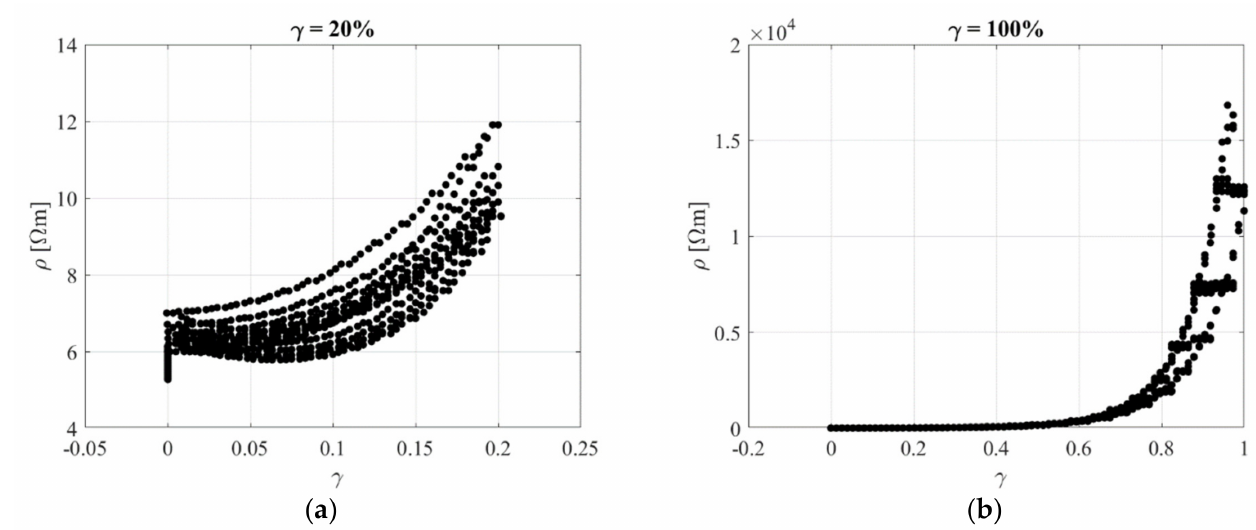
Figure 17. Resistivity vs. shear strain for different tests ( a ) γ max = 0.2 and ( b ) γ max = 1.